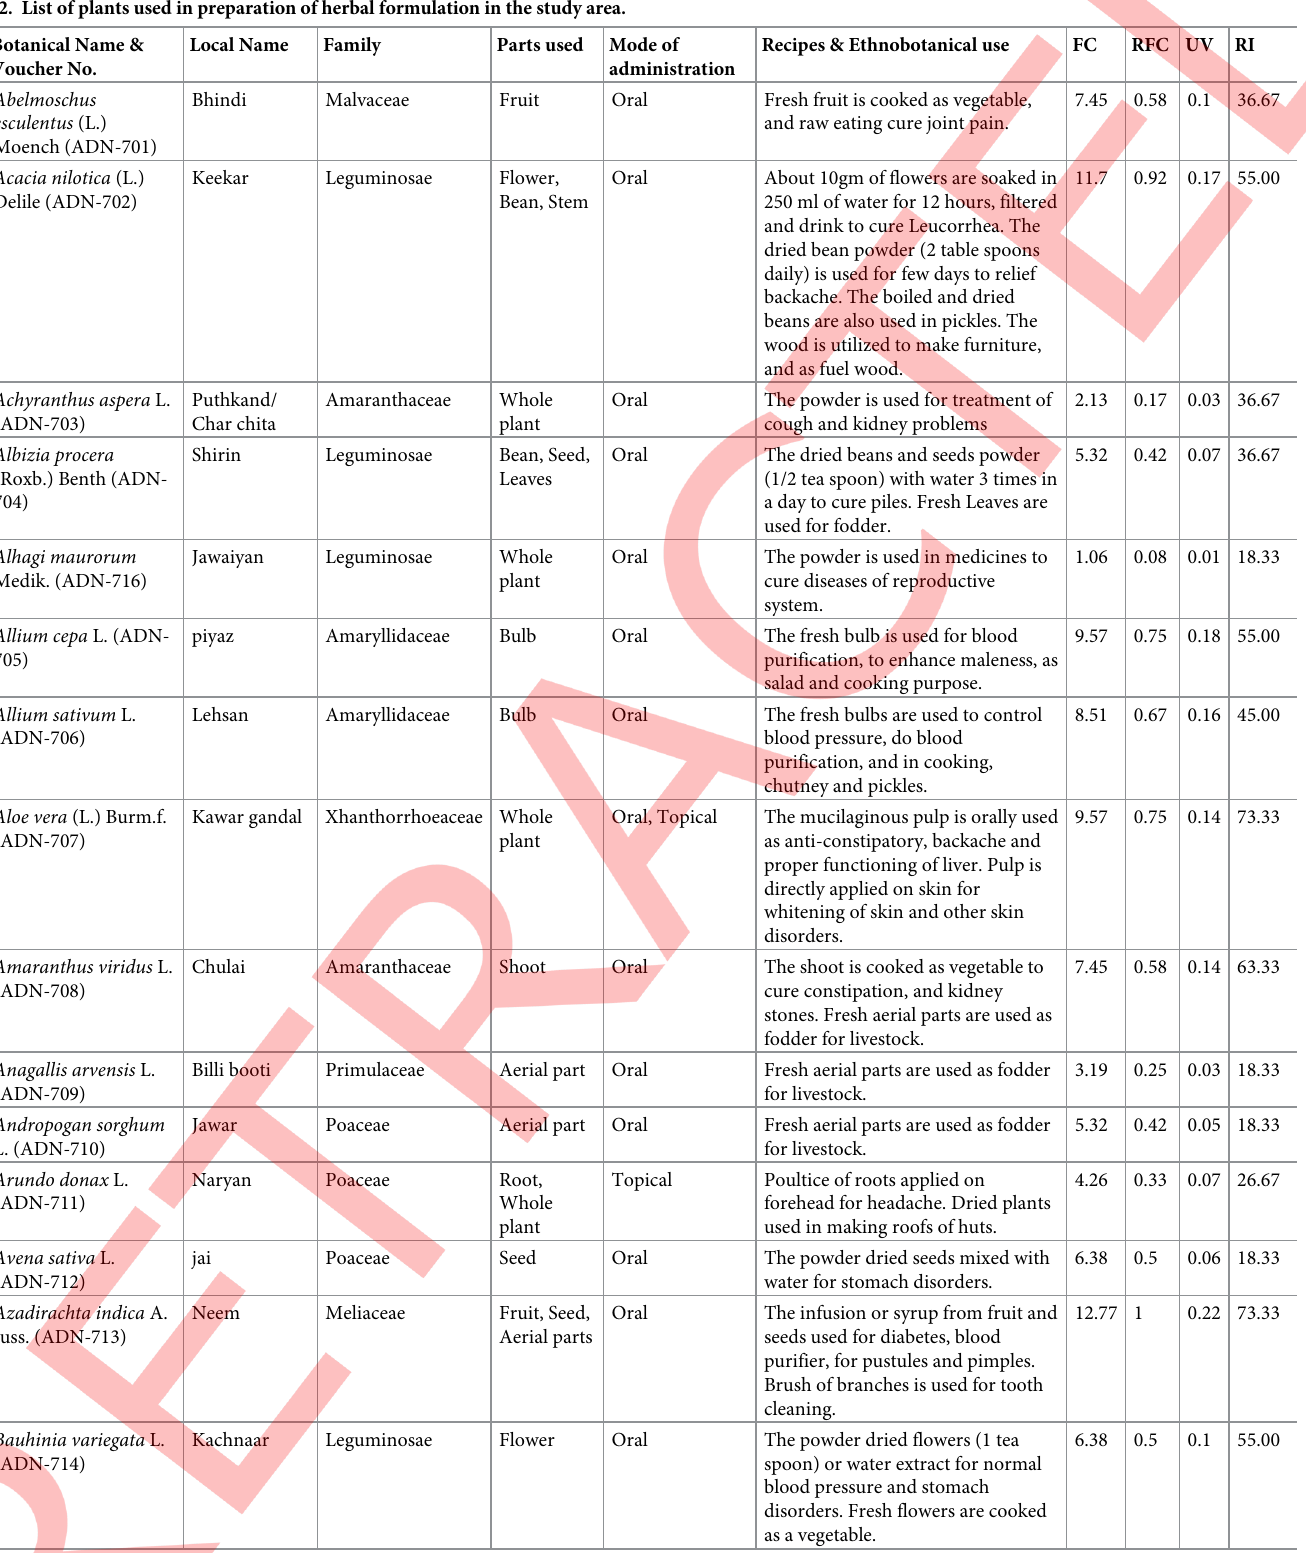
Table 2. List of plants used in preparation of herbal formulation in the study area.